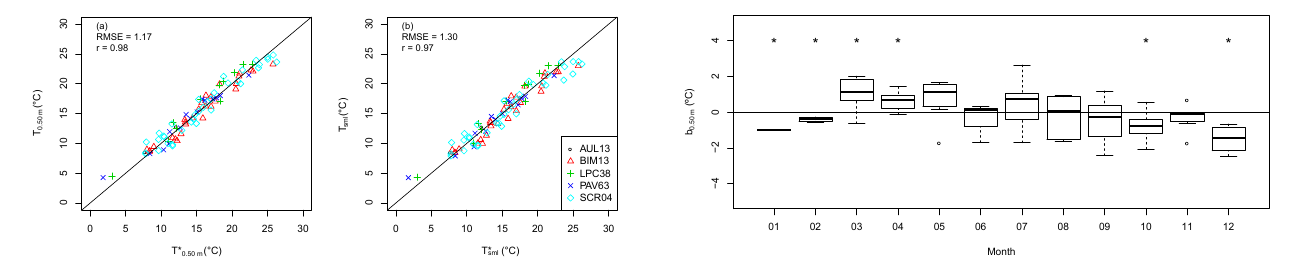
Figure 11. Comparison of satellite-based temperature estimations ( T *) and in situ temperatures ( T ): (a) temperature at 0.5m, (b) tem- perature of the surface mixed layer. The diagonal line represents the 1 : 1 relation.